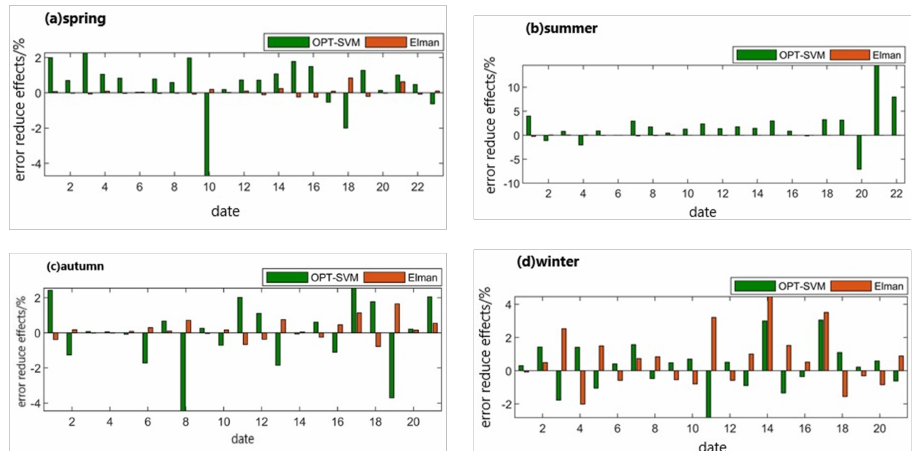
Figure 14. The forecast error reduction effects of the combined model by harmonic weighted average compared with the single models. ( a ) Spring (March 1 to June 3); ( b ) Summer (June 4 to September 3); ( c ) Autumn (September 4 to December 3); ( d ) Winter (December 4 to February 28 of the following year)